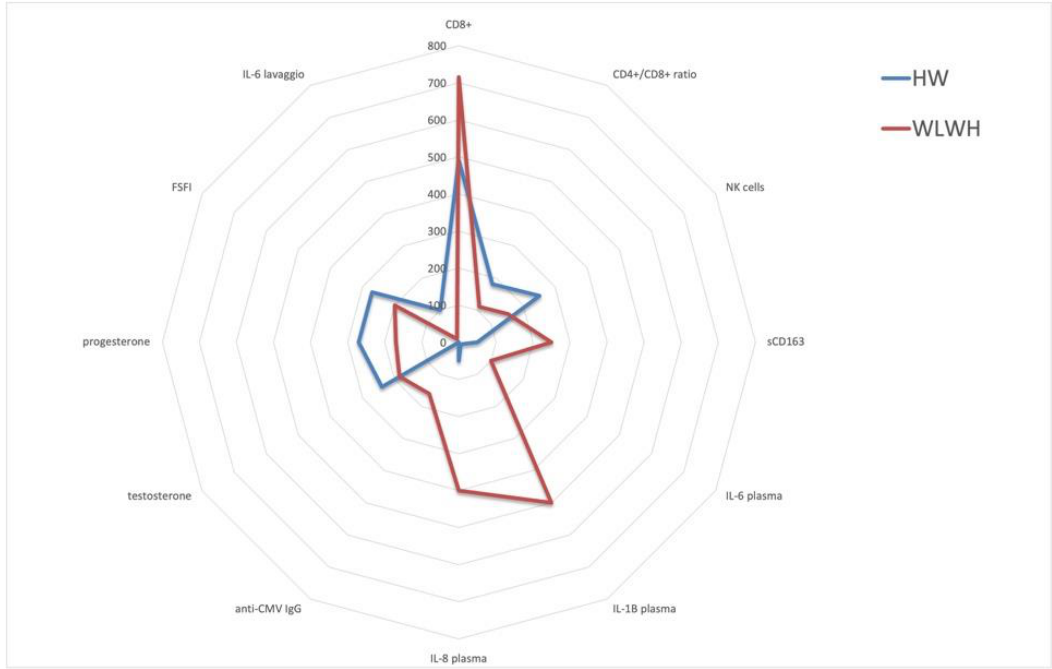
Figure 6. Representation of inflammatory, immunological, and sexual health markers: (CD4/CD8 ratio = cells/mm3; CD4+ = cells/mm3; NK cells = cells/mm3; sCD163 = soluble CD163; ng/mL; IL-6 = interleukin-6; pg/mL; IL-1beta = interleukin-1 beta; pg/mL IL-8 = interleukin-8 pg/mL; anti-CMV igG = IU/mL; testosterone; progesterone; FSFI) in plasma and vaginal lavage are represented by radar chart. Results are reported as estimated average variations. Radar plots were constructed scaling all variables in a range from 0% to 100% and plotting averages in WLWH and HW.